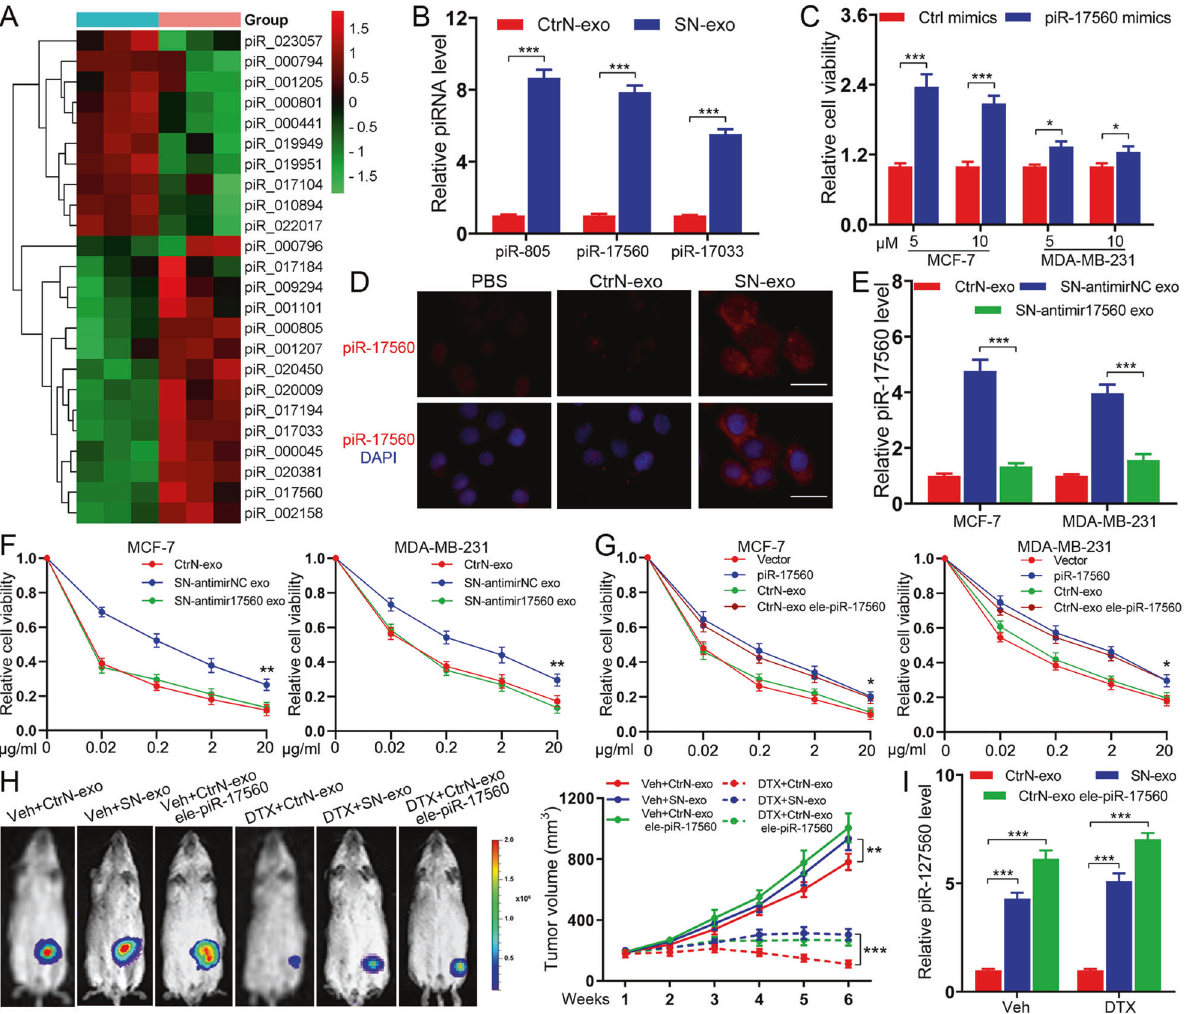
Fig. 3 Senescent neutrophils confer docetaxel resistance to BC cells through exosomal piR-17560. A Heatmap diagram of differential piRNA expression in senescent neutrophils-derived exosomes and control exosomes. Red, increased expression; green, decreased expression. B qPCR analysis of piRNA expression in the exosomes produced from control and senescent neutrophils. C The viability of cancer cells transfected with piRNA mimics followed by docetaxel at different concentrations for 48 h. D Representative image of immuno fl uorescence staining showing the expression of piR-17560 in MCF-7 cells treated with indicated exosomes (PBS as control) for 48 h. Scare bars, 50 μ m. E qPCR analysis of piR-17560 expression in tumor cells cultured with indicated exosomes for 48 h. F CCK8 assay of cancer cells pre-incubated with indicated exosomes for 48 h followed by docetaxel at different concentrations for 48 h. G CCK8 assay of cancer cells transfected with piR- 17560 plasmids or incubated with indicated exosomes followed by docetaxel administration for 48 h. H In vivo xenograft assay of MCF-7 cells in nude mice with intratumoral injection of indicated exosomes upon docetaxel (10 mg/kg) or vehicle treatment. Representative bioluminescent images of mice in indicated groups are shown (left). Tumor volumes are shown ( n = 5 per group, right). I qPCR analysis of